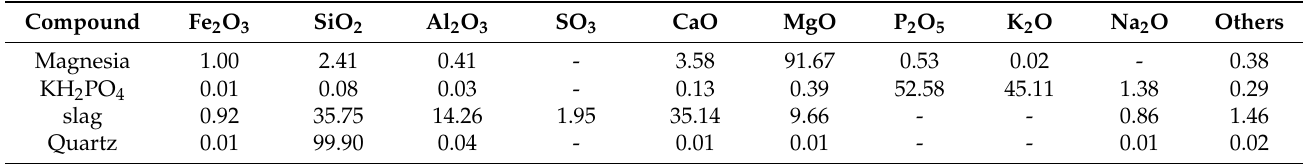
Table 1. Chemical compositions of raw materials ( wt